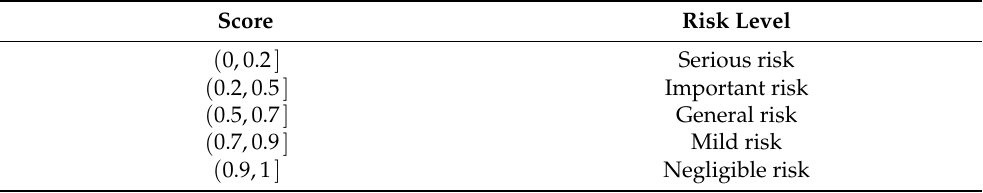
Table 5. Risk level